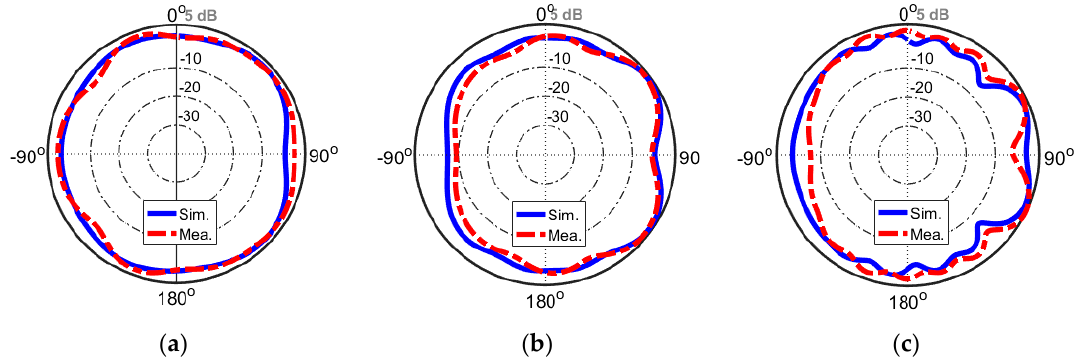
Figure 13. Two-dimensional radiation patterns at ( a ) first (2.6 GHz), ( b ) second (3.6 GHz), and ( c ) third (5.8 GHz) resonances.